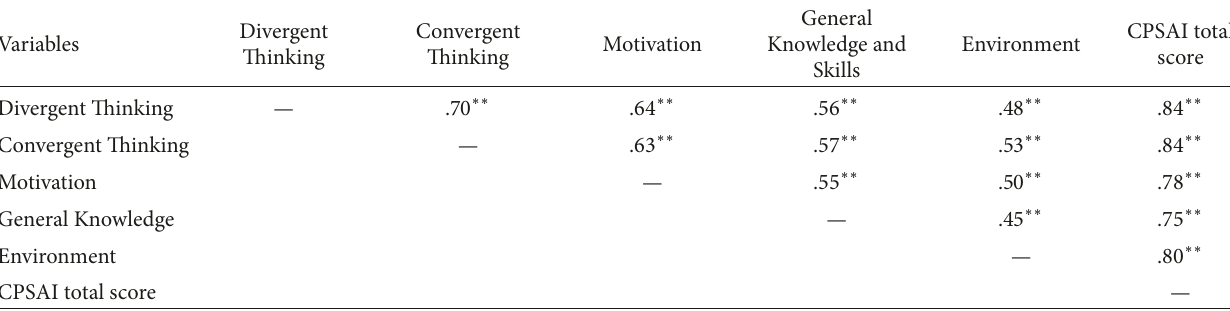
Table 3: Correlation coefficients between students’ responses on five subscales and CPSAI overall score.